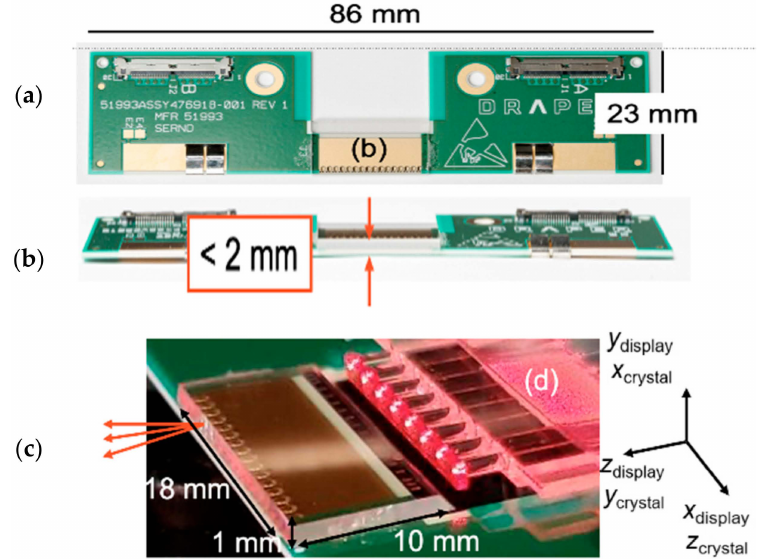
Figure 18. ( a ) An LFPM is a <2 mm-thin edge-emitting device intended to be arrayed into elec- troholographic light field projection systems, such as displays. This first-generation LFPM has a leaky mode modulator ( b ) that is flip-chip bonded to a circuit board. It also includes a backlight subassembly shown in the detail at ( c ), in which eight gradient index (GRIN) rod lenses ( d ) with integrated illumination fibers have been aligned to simultaneously excite the same waveguide mode in 8 modulator channels at a 2 mm pitch. Reproduced with permission from [9].